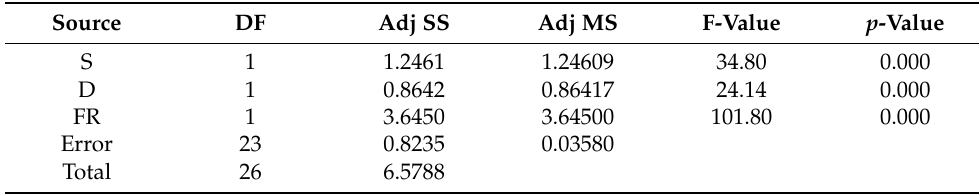
Table 8. ANOVA results for Ra using wiper cutting edge.